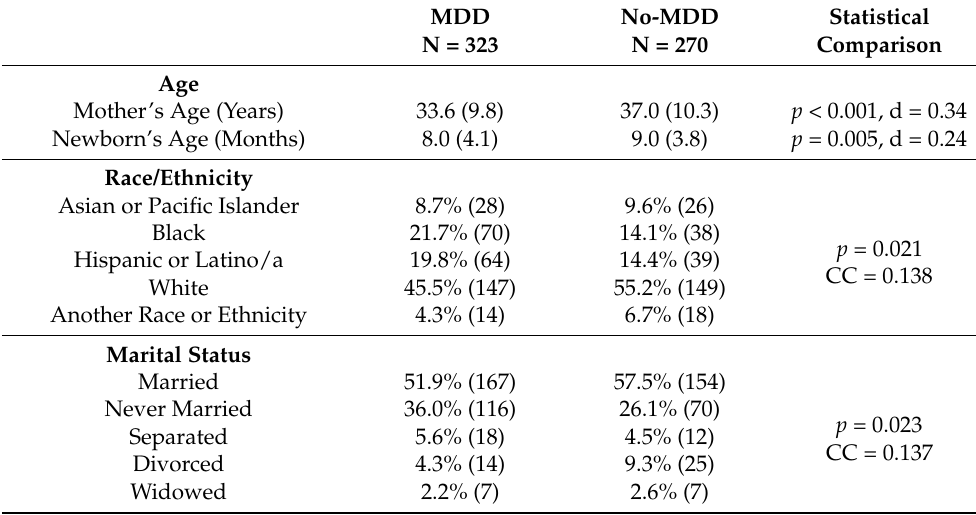
Table 1. Demographic Comparisons (N =